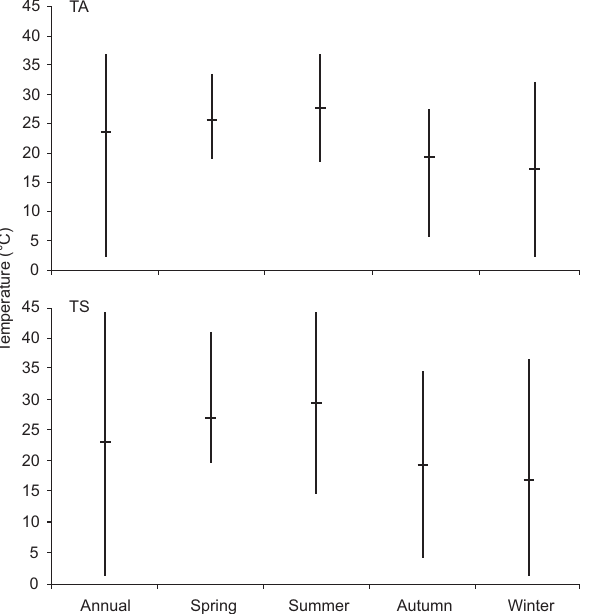
Figure 1. Annual and seasonal variation of environmental tem- peratures recorded in the study area in the municipality of Bom Jesus between October 2006 and September 2007. (TA) Air tem- perature, (TS) substrate temperature. Bars represent mean tem- peratures.